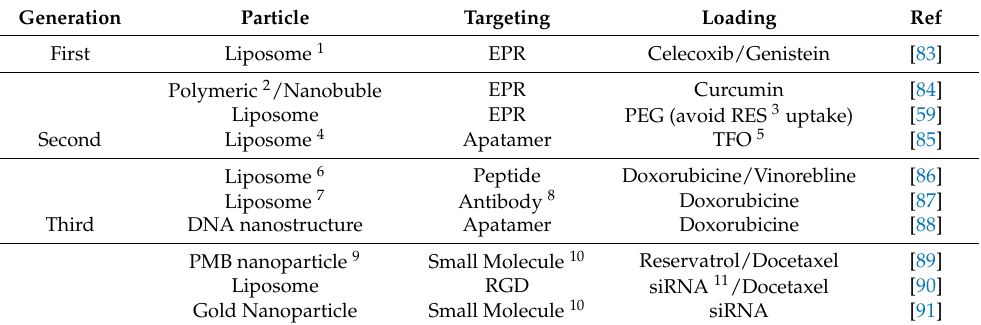
Table 3. Tabulation of the Nanoparticle currently used for prostate cancer, their bioactive ingredients and